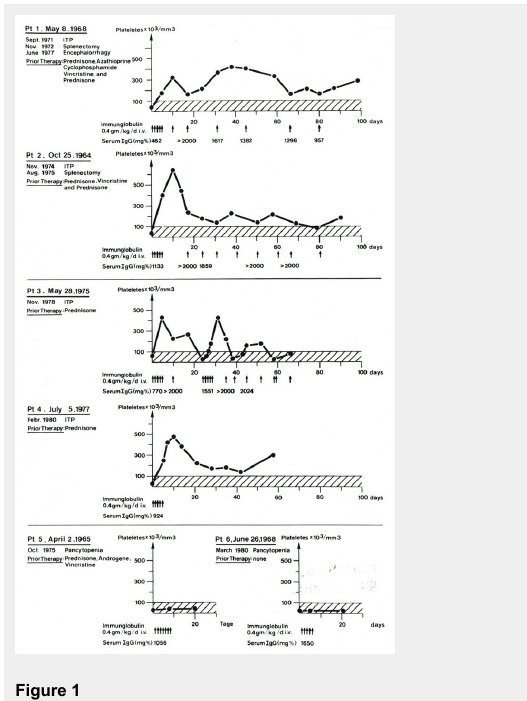
Pilotstudy 1 with controls. Response rate of IVIG during the first 80 days, 20 days respectively, of observation. Patient 1 is the key patient with ITP and secondary hypogammaglobulinaemia. Patients 2–4 with ITP, but with normal serum IgG levels. Patients 5 and 6 with aplastic anaemia and no response to IVIG. Arrow means 0.4 g IVIG per kilogram body weight/day. Serum IgG in mg% (© Imbach P, Barandun S, Baumgartner C, Hirt A, Hofer F, Wagner HP. High-dose intravenous immunoglobulin therapy of